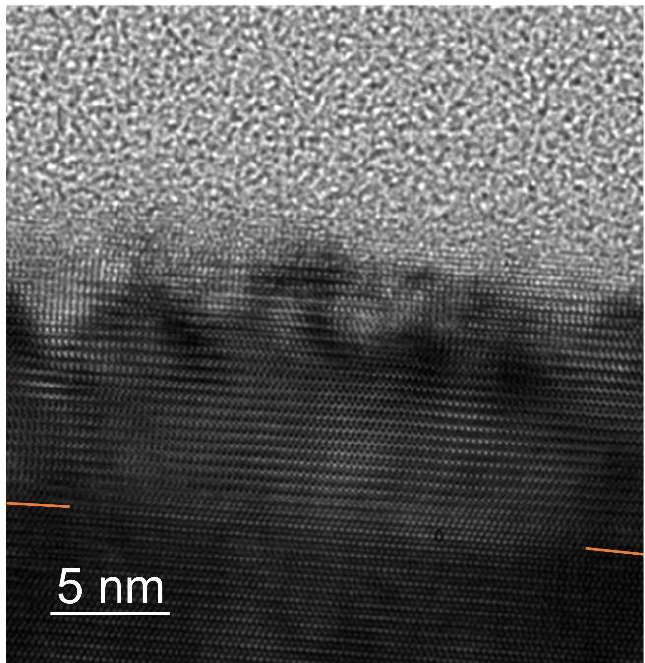
Figure 8. TEM cross-section showing the LT AlN/high temperature GaN interface of sample A2, grown with NH 3 . The orange lines indicate the interface between AlN and GaN.